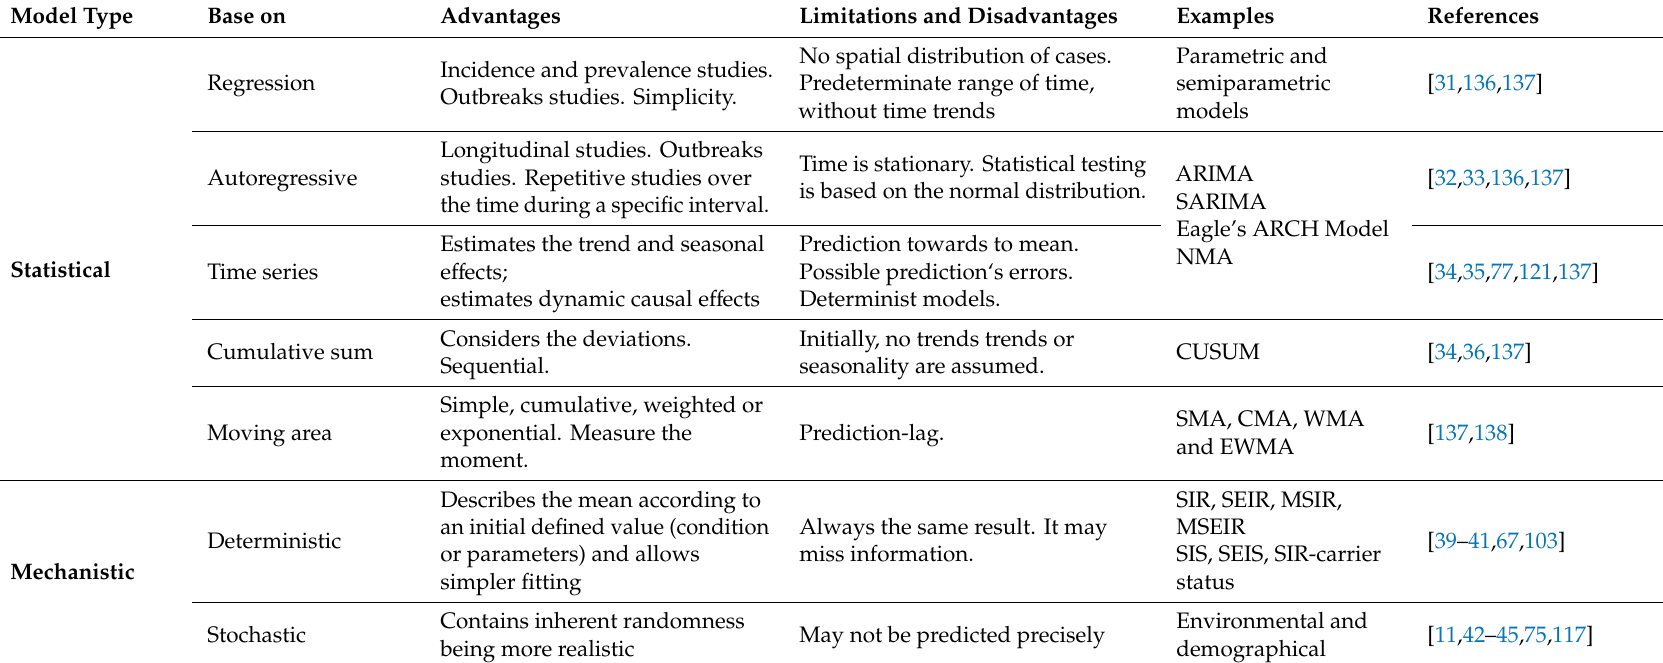
Table A1. Advantages and limitations of individually mentioned mathematical models applied to modelling infectious diseases. It is shown the main advantages and limitations together most relevant models. Likewise, it is only shown the individual models base on statistical mathematical model and not the combination among